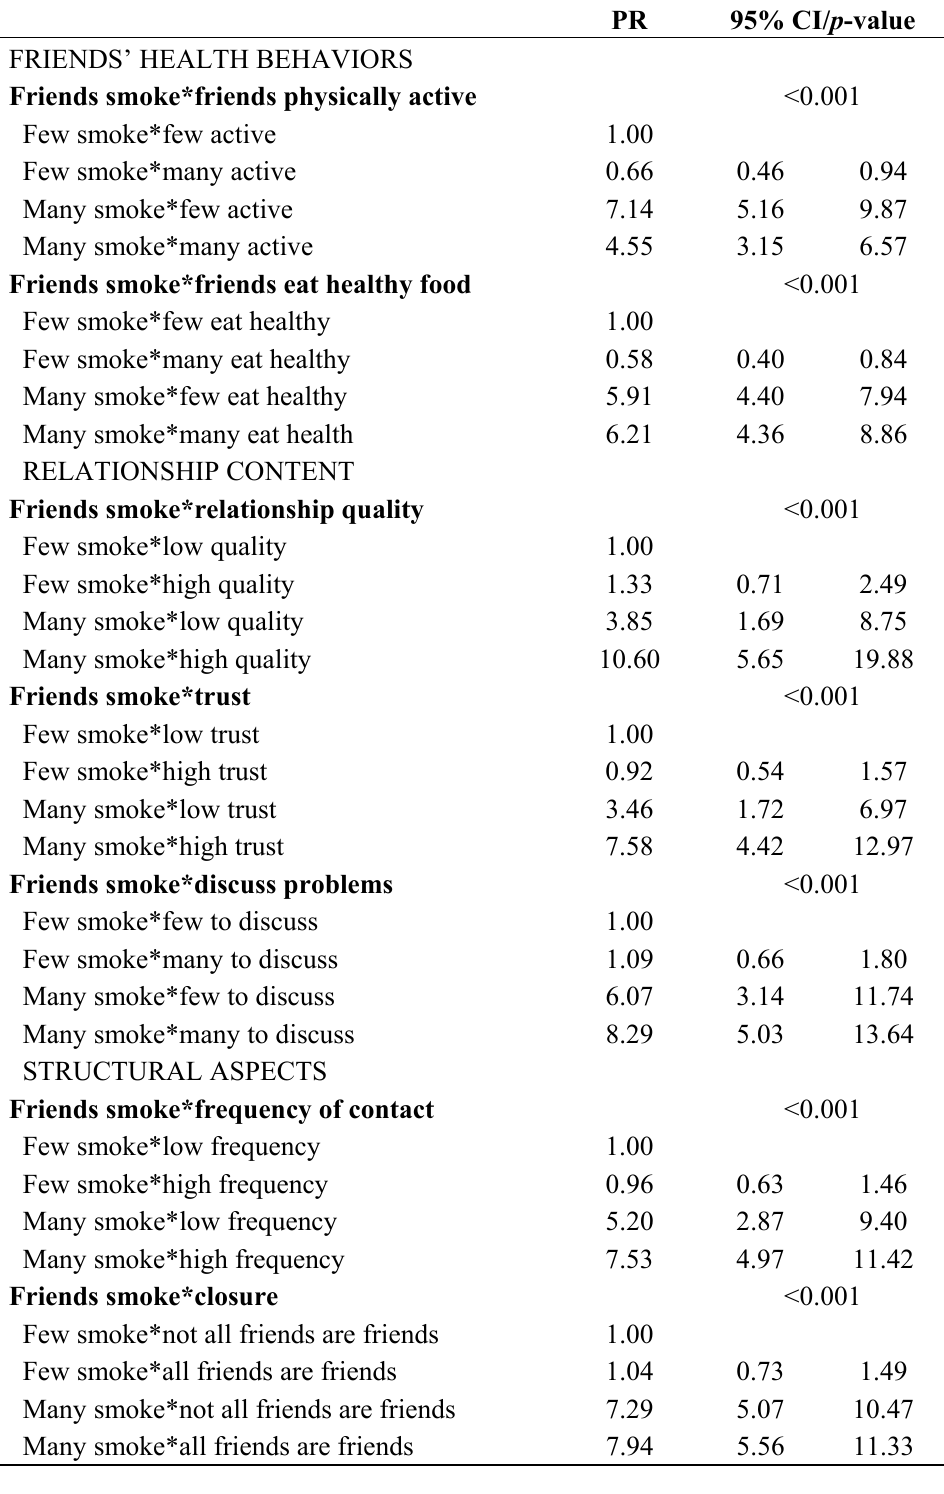
Table 4. Interaction between friends who smoke and other network characteristics and sociodemographic variables, 19-year-old men and women (adjusted for parents’ country of birth, social class, civil status, school grades, gender, ego’s alcohol consumption, ego’s physical activity and ego’s eating habits), prevalence ratios